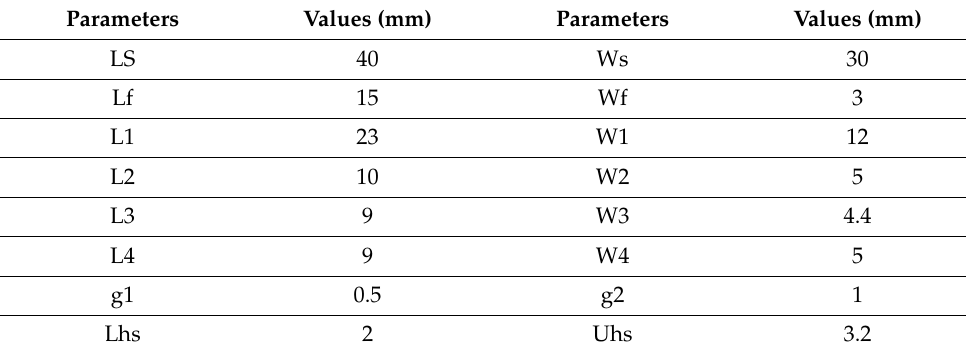
( c ) Figure 3. Proposed antenna design steps: ( a ) simple rectangular patch (ANT I), ( b ) patch with L- shape slots in the upper side (ANT II), ( c ) proposed patch (ANT III). The patch’s width and length are calculated using Equations (1) and (2) [23], as fol- lows: